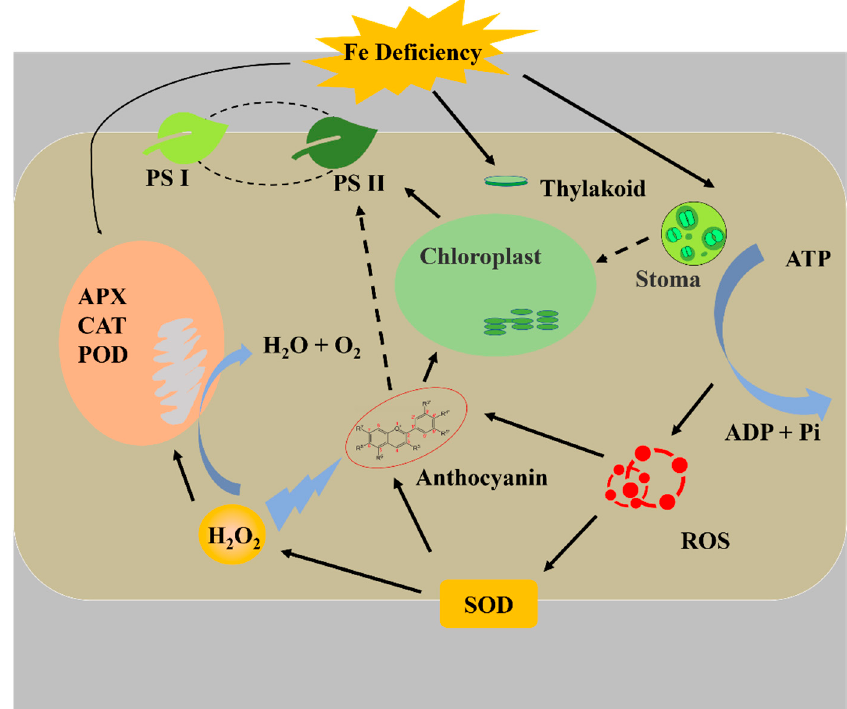
Figure 10. The relational model of Fe deficiency with antioxidant system and photosynthesis. The control of the Fe-homeostasis is handled at the genetic level. First, the reduction of the ferric chelates by ferric reductase is an obligatory step in Strategy I plants. Over- expression of FRO2 in Arabidopsis thaliana was observed to correspond with a significant increase in the tissue content of Fe [84]. Meanwhile, the AtFRO2 is controlled by a tran- scriptional factor FER , reported to be the spontaneous mutant T3238fer , which is unable to activate Fe-deficiency responses under low Fe conditions, which includes but is not limited to the expression of FRO and the activity of ferric chelate reductase [85]. In this study, Fe deficiency upregulated the expression of Hm-AtFRO2 and Hm-AtFER1 , whereas the Hm-AtFER1 in the control at pH 5.70 was significantly higher than that in the control group at the other two pH levels, which is speculated to be related with the underlying FER regulatory pathway in strategy I. The detailed mechanisms involved remain to be revealed. Second, once inside the roots, Fe is transported over long distances via the veins to the tissues by transpiration. Previous researchers have found that aerial part of the plant has a key role in the distribution and regulation of Fe, in both strategy I and strategy II plants, intracellular delivery of Fe and trafficking within the plant is dependent on NA, which chelates and transports micronutrient metal ions. The lack of NA would decrease the mobility and availability of Fe, as well as form precipitation in the chloroplast and phloem sap [22]. The Fe-NA complexes are transferred from the xylem to the neighboring cells through the YSL proteins in Arabidopsis [86]. These are regulated by NAS and YSL . Analysis of the Fe-sufficient and Fe-deficient transcriptome in Arabidopsis revealed